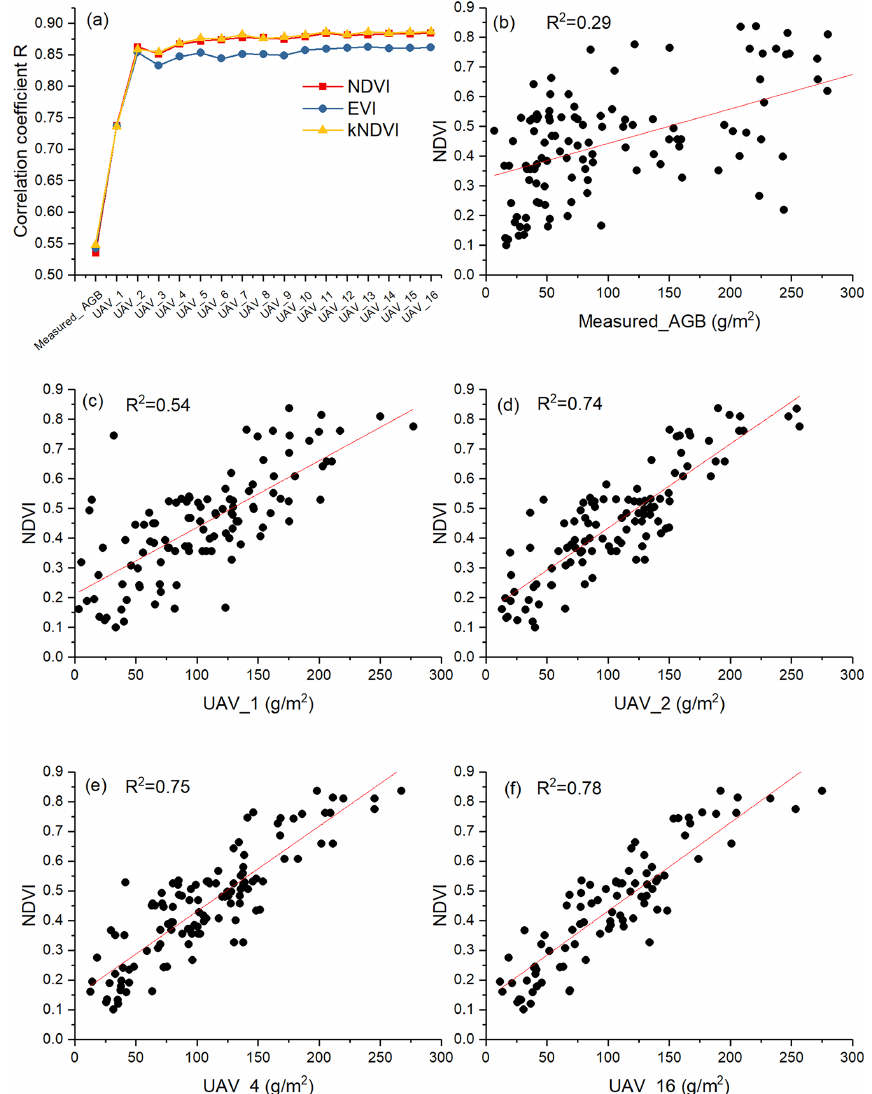
Figure 7. Correlation between MODIS vegetation indices and different AGB estimation methods (a) . Scatterplots of NDVI with different AGB estimation methods (b–f) . UAV_ x represents the number of UAV photos used to estimate the average AGB at the MODIS pixel scale. Here, x ranges from 1 to